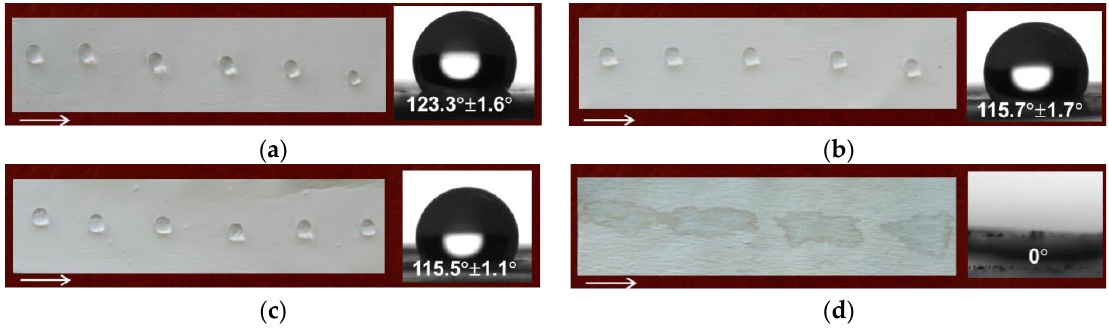
Figure 4. Images of water droplets deposited on the surfaces of mats from: ( a ) PHB; ( b ) PVP in PHB; ( c ) PVP,CQ in PHB; and ( d ) PVP,CQ on PHB. The direction of the collector rotation is demonstrated by an arrow.